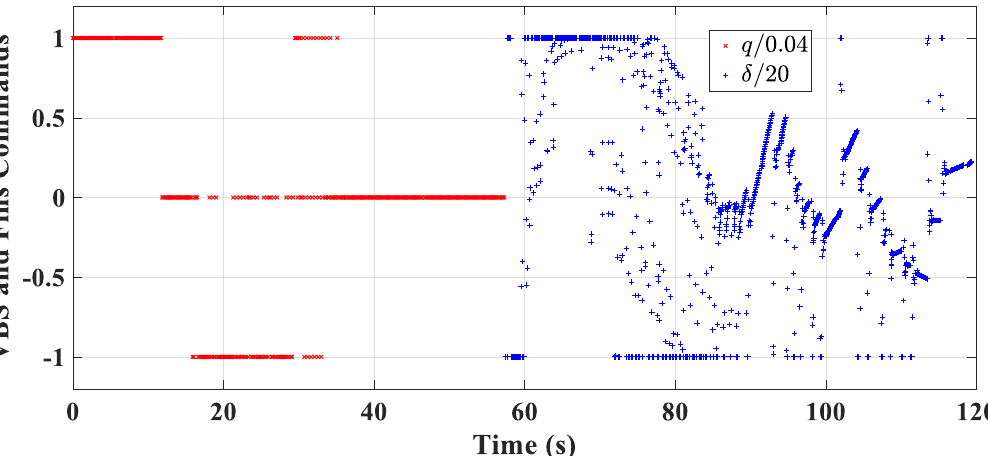
J. Mar. Sci. Eng. 2020 , 8 , 181 Figure 15. Normalized VBS and fins commands of depth control under combined control strategy.